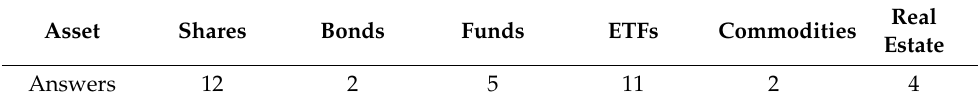
Table 3. The number of votes for each asset by the higher-risk participants. Asset